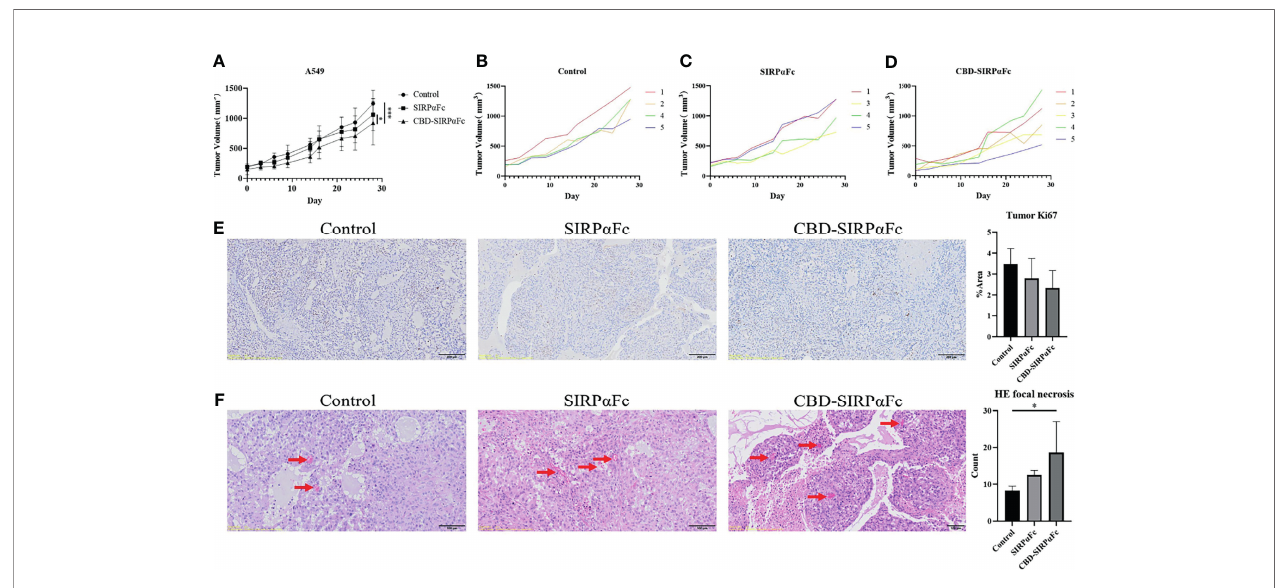
FIGURE 5 | CBD conjugation improved the antitumor ef fi cacy of SIRP a Fc in vivo . (A – D) A total of 1 × 10 7 A549 cells were resuspended in 200 m l PBS then inoculated subcutaneously at the right fl ank of each BALB/c nude mouse to establish the xenograft model. Mice were administrated intraperitoneally with PBS, 10 mg/kg SIRP a Fc, or CBD – SIRP a Fc for 28 days. Tumor volumes were measured and analyzed with two-way ANOVA in GraphPad Prism 8 software between groups (n = 5 for the CBD – SIRP a Fc group and n = 4 for the control group and SIRP a Fc group, mean ± SD, * p < 0.0332, *** p < 0.0002) (A) or in a single group (B – D) . One mouse in the control group and one in the SIRP a Fc group died before the terminal. (E) Ki67 immunohistochemistry staining was performed to study the proliferation in tumor. Tumors in the control group showed a more severe trend of proliferation than the SIRP a Fc and CBD – SIRP a Fc group. Proportions of the positive area were counted by ImageJ software and analyzed by one-way ANOVA in GraphPad Prism 8 software (n = 5 for the CBD – SIRP a Fc group and n = 4 for the control group and SIRP a Fc group, mean + SD). (F) Hematoxylin – eosin (H-E) staining was performed to study the necrosis in tumors. Focal necrosis indicated by red arrows were more and larger in the SIRP a Fc and CBD – SIRP a Fc group than in the control group. Focal necrosis in all samples was counted and analyzed by one-way ANOVA in GraphPad Prism 8 software (n = 5 for the CBD – SIRP a Fc group and n = 4 for the control group and SIRP a Fc group, mean + SD, * p <